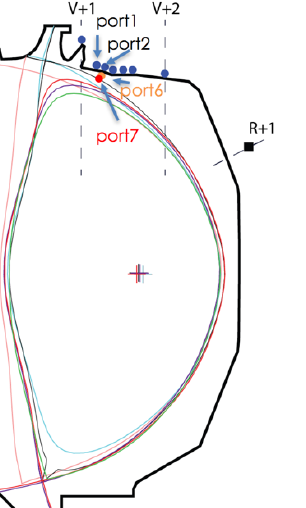
Figure 7:The launch locations and plasma shapes used in the physics feasibility study of Top launch ECCD on DIII-D